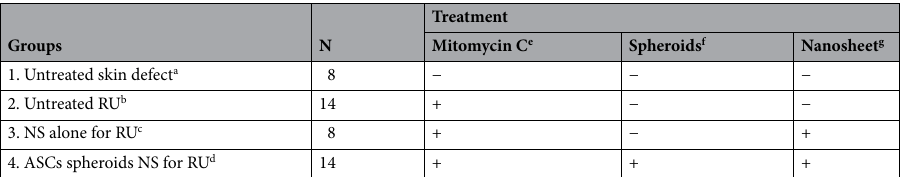
Table 1. Experimental animal groups for evaluation of wound healing. a No treatment after removal of skin and subcutaneous tissue. b No treatment for mitomycin C-induced refractory ulcer. c Treatment by the nanosheet without ASC spheroids for mitomycin C-induced refractory ulcer. d Treatment by the nanosheet carrying ASC spheroids for mitomycin C-induced refractory ulcer. e Topical application of mitomycin C onto the wound. f Transplantation of 2 × 10 2 spheroids onto the wound. g Application of a nanosheet onto the wound.